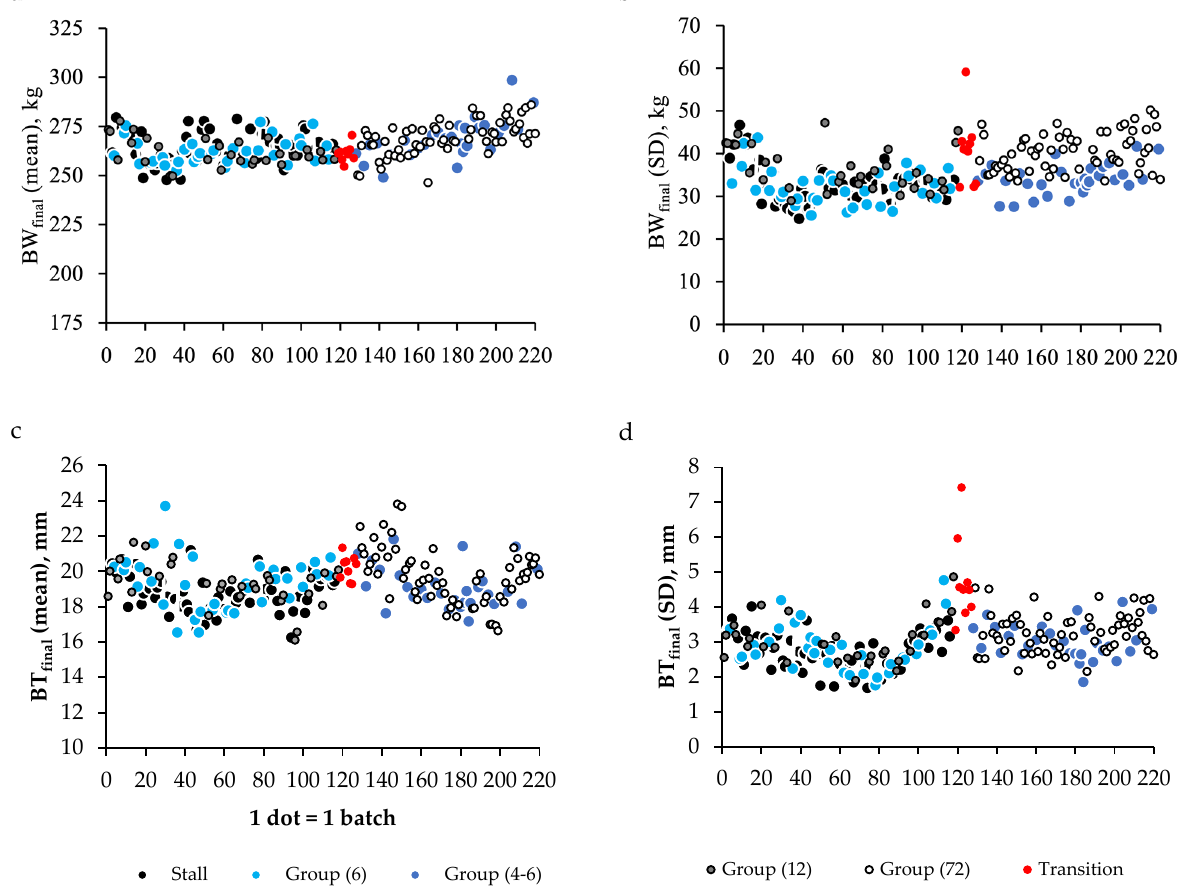
Figure 4. Mean and standard deviation (SD) of body weight after farrowing (BW final , ( a , b )) and backfat thickness at farrowing (BT final , ( c , d )) calculated per batch from cycles 20–56 (220 batches), housed in different systems: individual stalls, small groups (6 sows per pen) or large groups (12 sows per pen) for the entire gestation period for the first 118 batches; in a transition system (without individualized feed allowance) when the farm was under reconstruction for 9 batches; and, small groups (4–6 sows per pen) or large groups (up to 72 sows per pen from 3 batches housed simultaneously) for the group-housed phase of the gestation period for the last 93 batches.